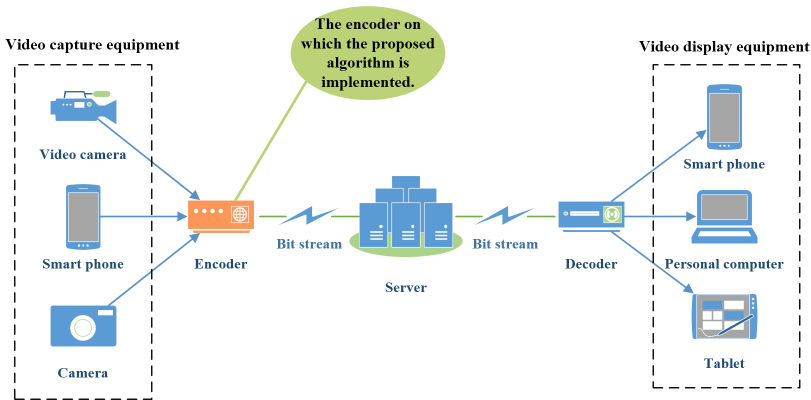
Figure 15. The application of the proposed research. Part in orange is where our algorithm works.